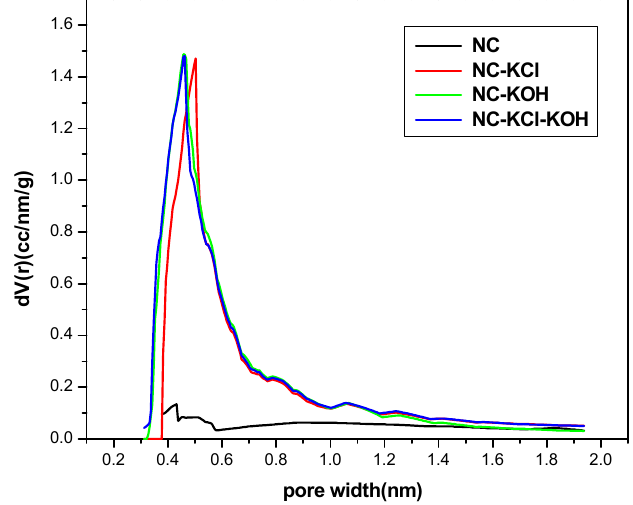
Figure 11. The micropore size distribution of typical samples.